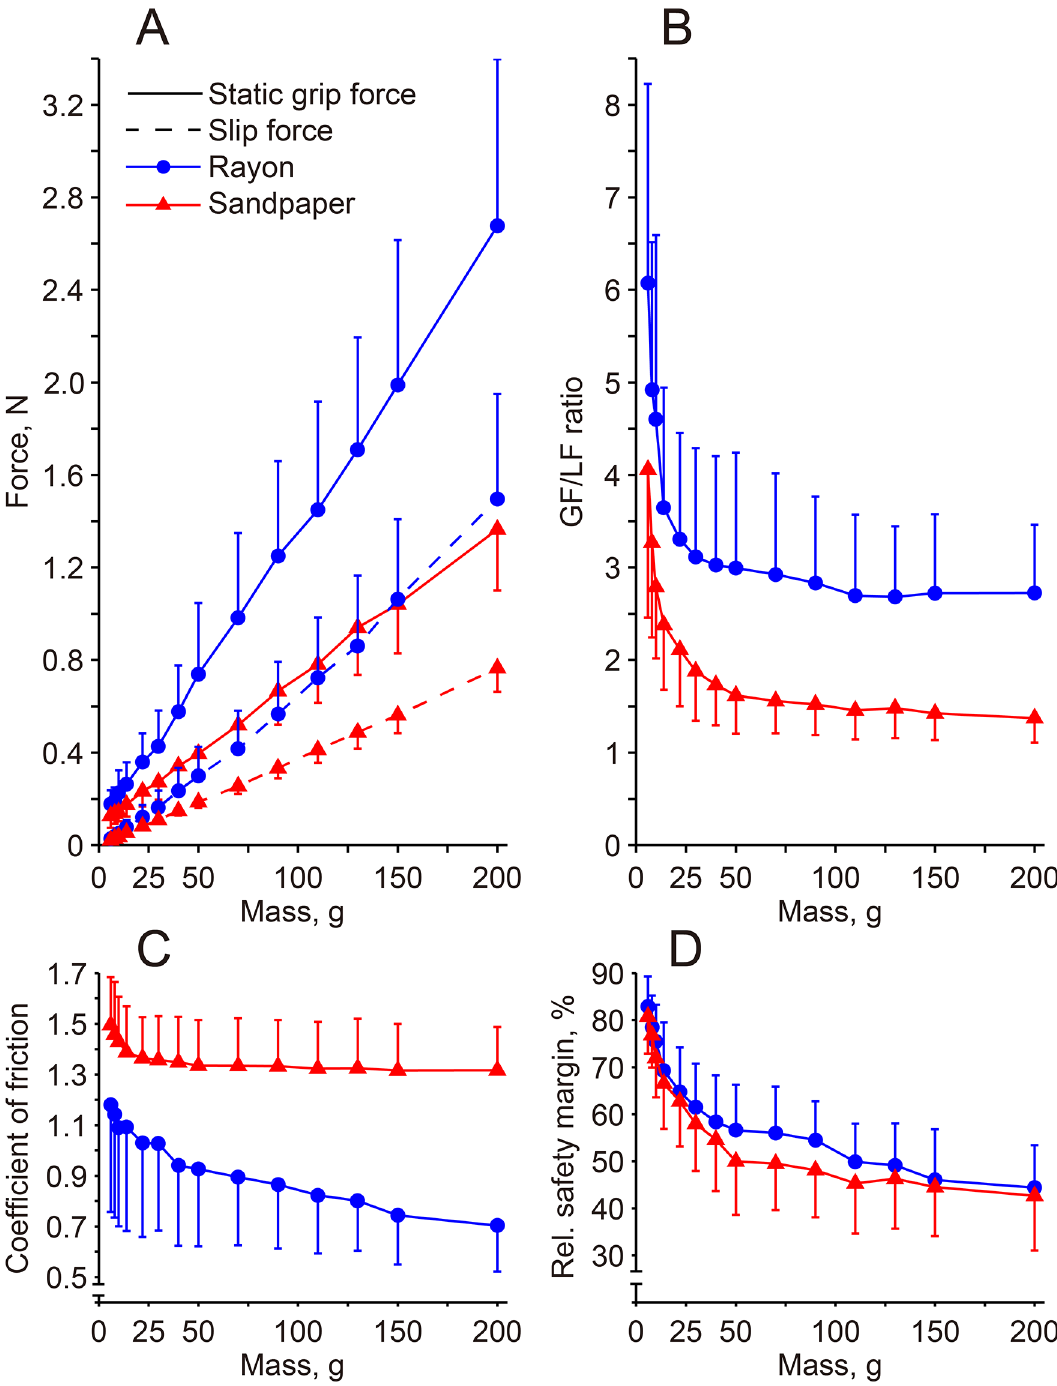
Fig 3. Changes in the static grip force and slip force (A), grip-to-load force (GF/LF) ratio (B), coefficient of friction (C), and relative safety margin (D) in relation to object mass for each surface condition. The data represent the mean and standard deviation (vertical bars) values of 17 subjects.